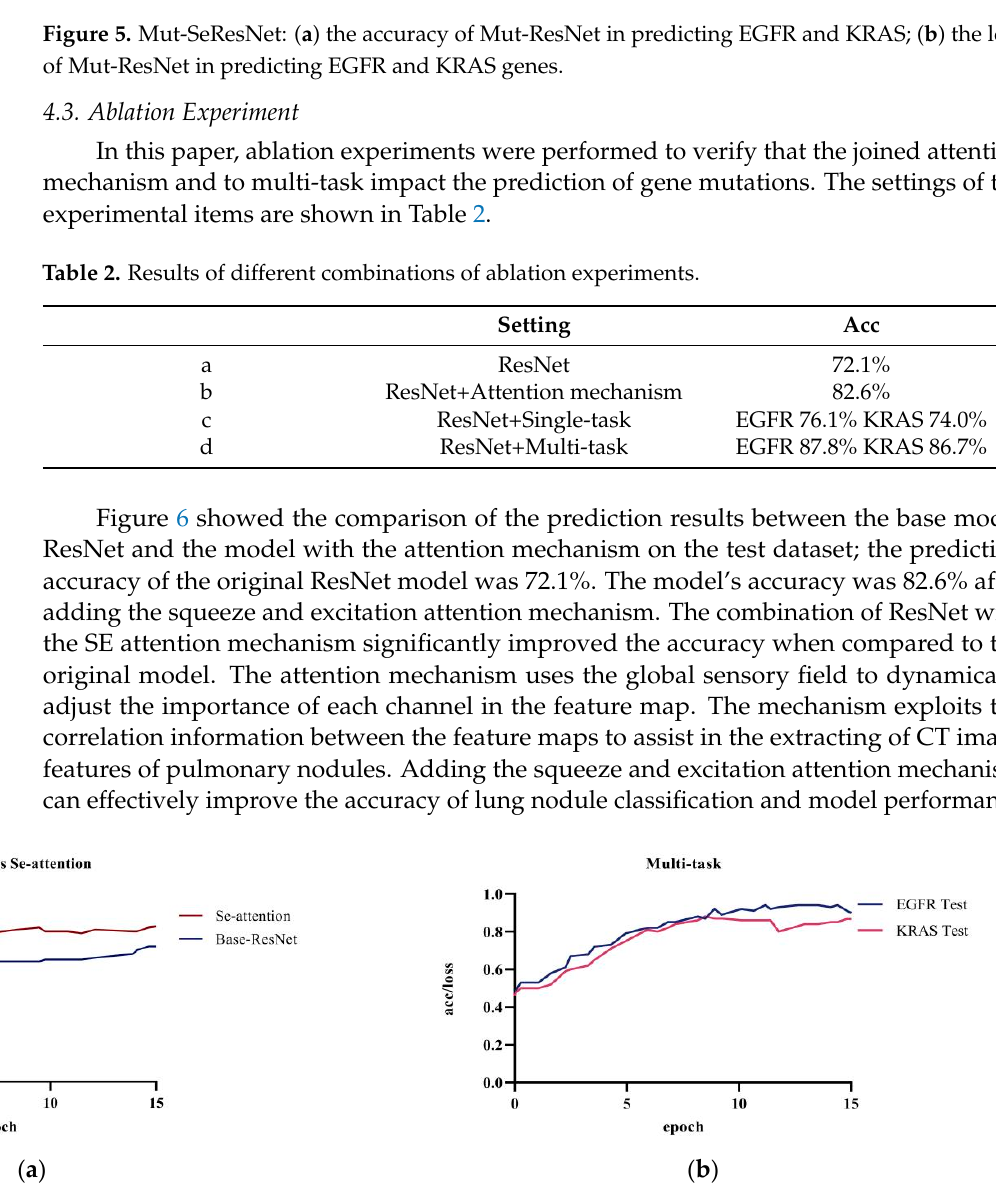
( b ) Figure 7. E xperiment c: ( a ) single-task training in the ResNet network to predict EGFR gene; ( b ) single-task training in the ResNet network to predict KRAS gene. 4.4. Visualization of the Models 4.4.1. Single-Task versus Multi-Task Attention A visualization of the single-task versus multi-task attention to nodules was made to further illustrate the results.